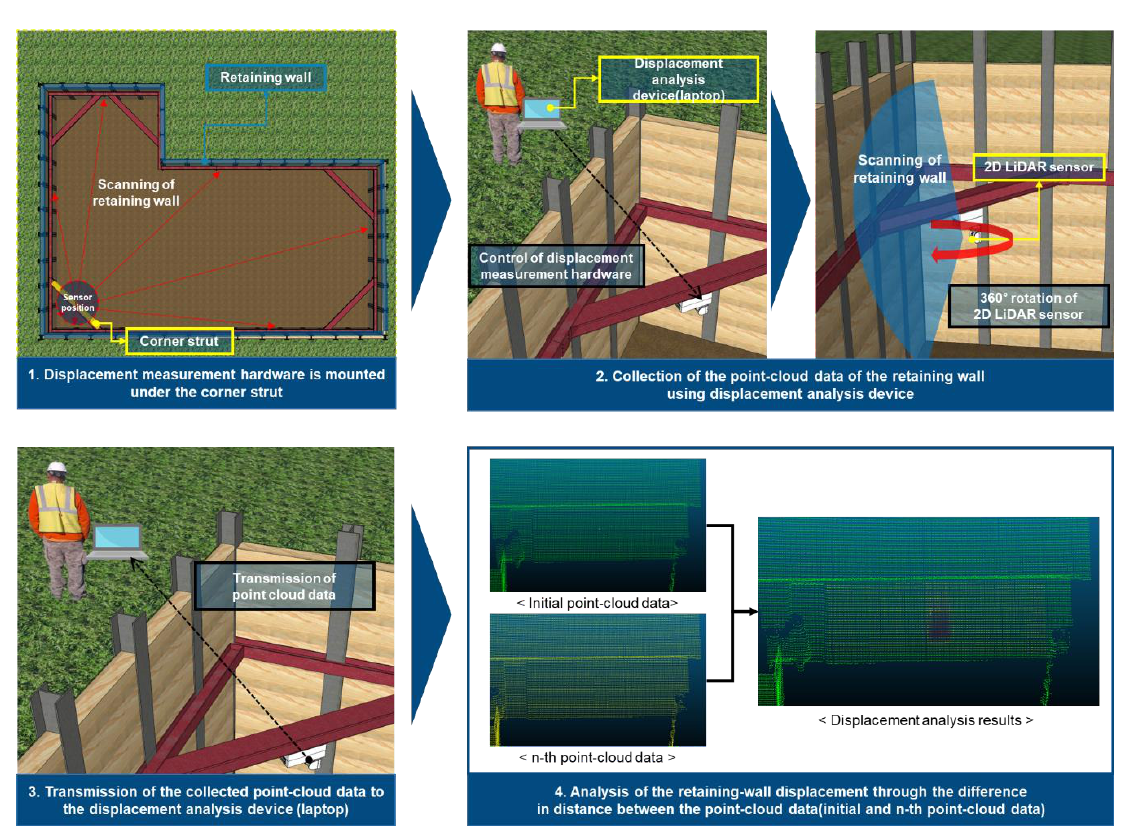
Figure 2. Measurement method of the 2D LiDAR sensor-based retaining wall displacement meas- urement system.